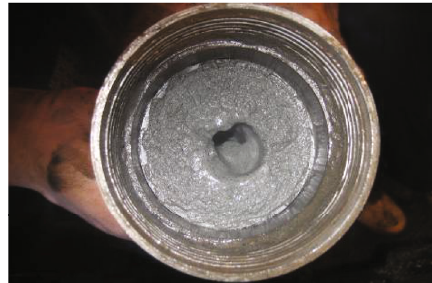
Figure 2: GZK1 pasted by loose back fi ll.